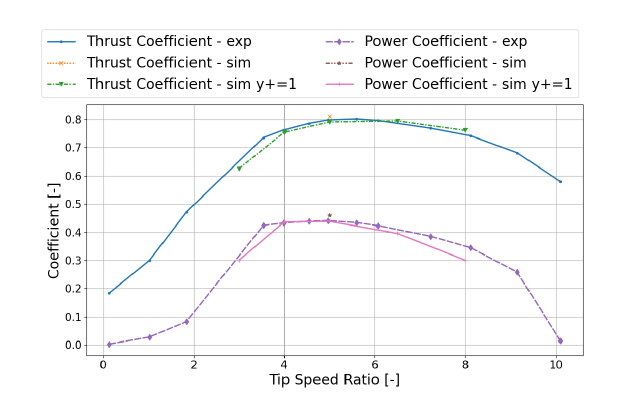
Fig. 5. Power and thrust coefficient for single turbine configura- tion. exp: experimental data. sim: simulation with wall function for boundary layer. sim y+=1: simulation with resolved boundary